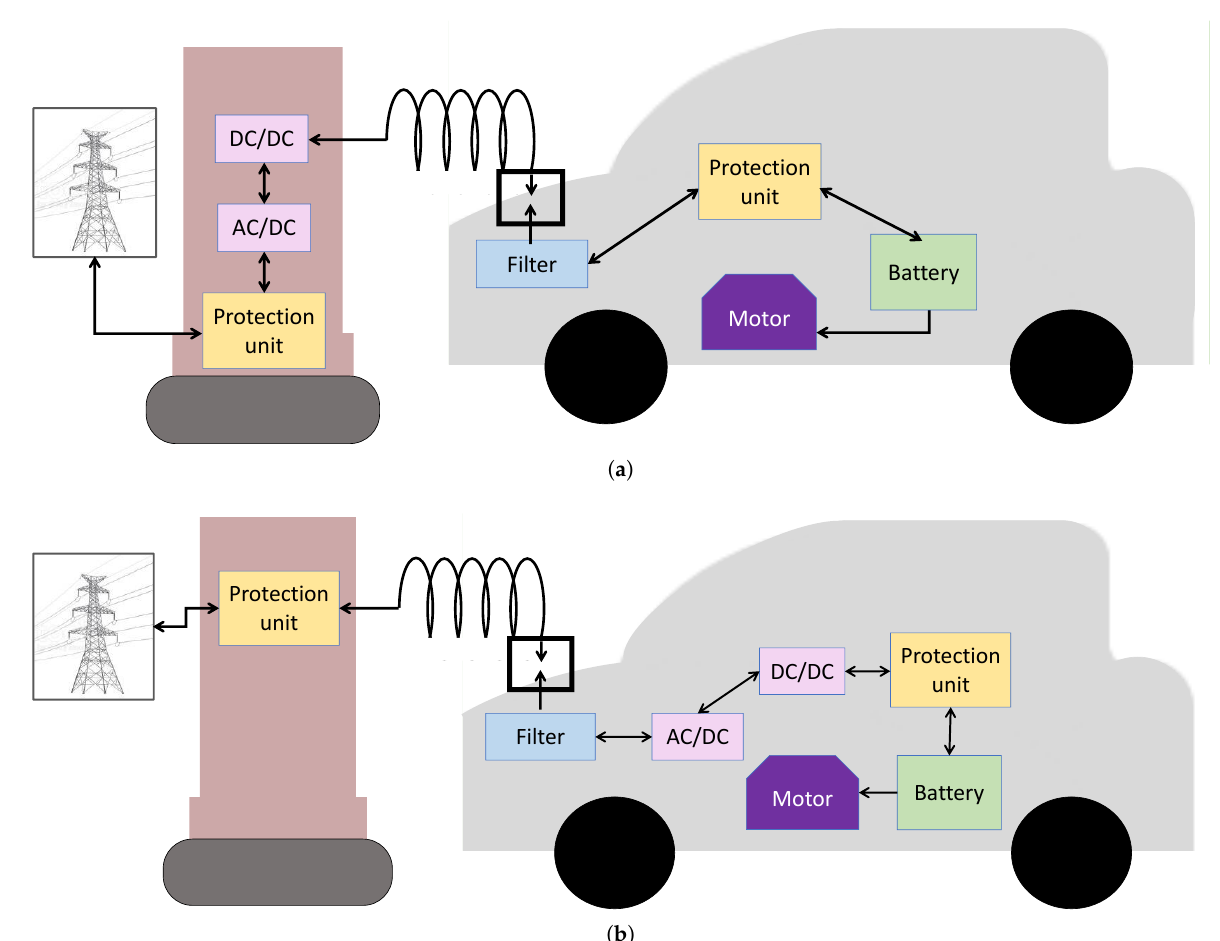
Figure 8. Schematic diagram of EV charging infrastructure. ( a ) AC charging stations. ( b ) DC charging